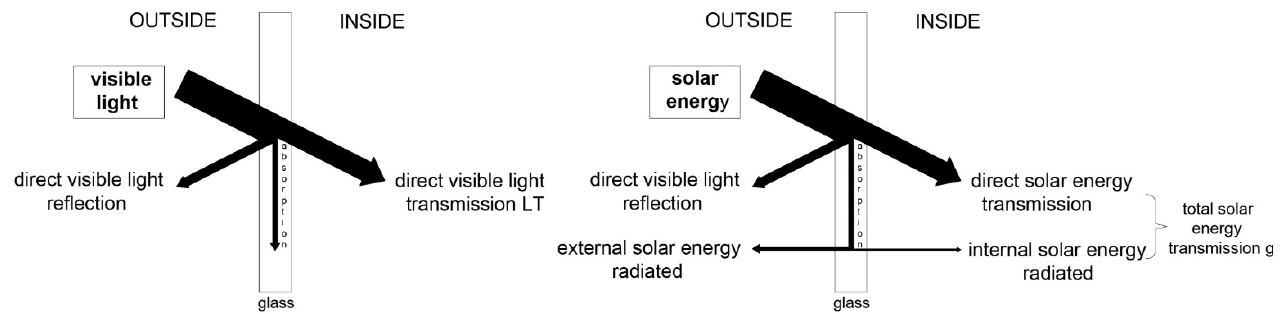
Figure 3. Schematic of the transmission of visible light and solar energy through glass panes (figure by the author).